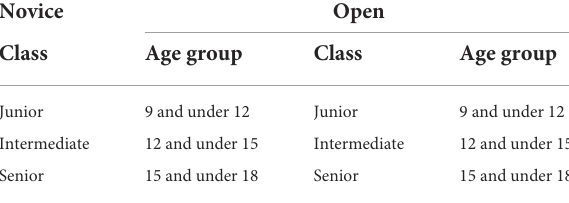
TABLE 1 Age breakdown of divisions for each class within the Junior Showmanship program. Novice